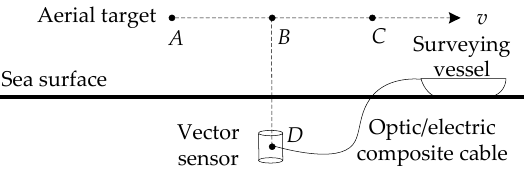
Figure 10. The profile of the sea experiment layout.